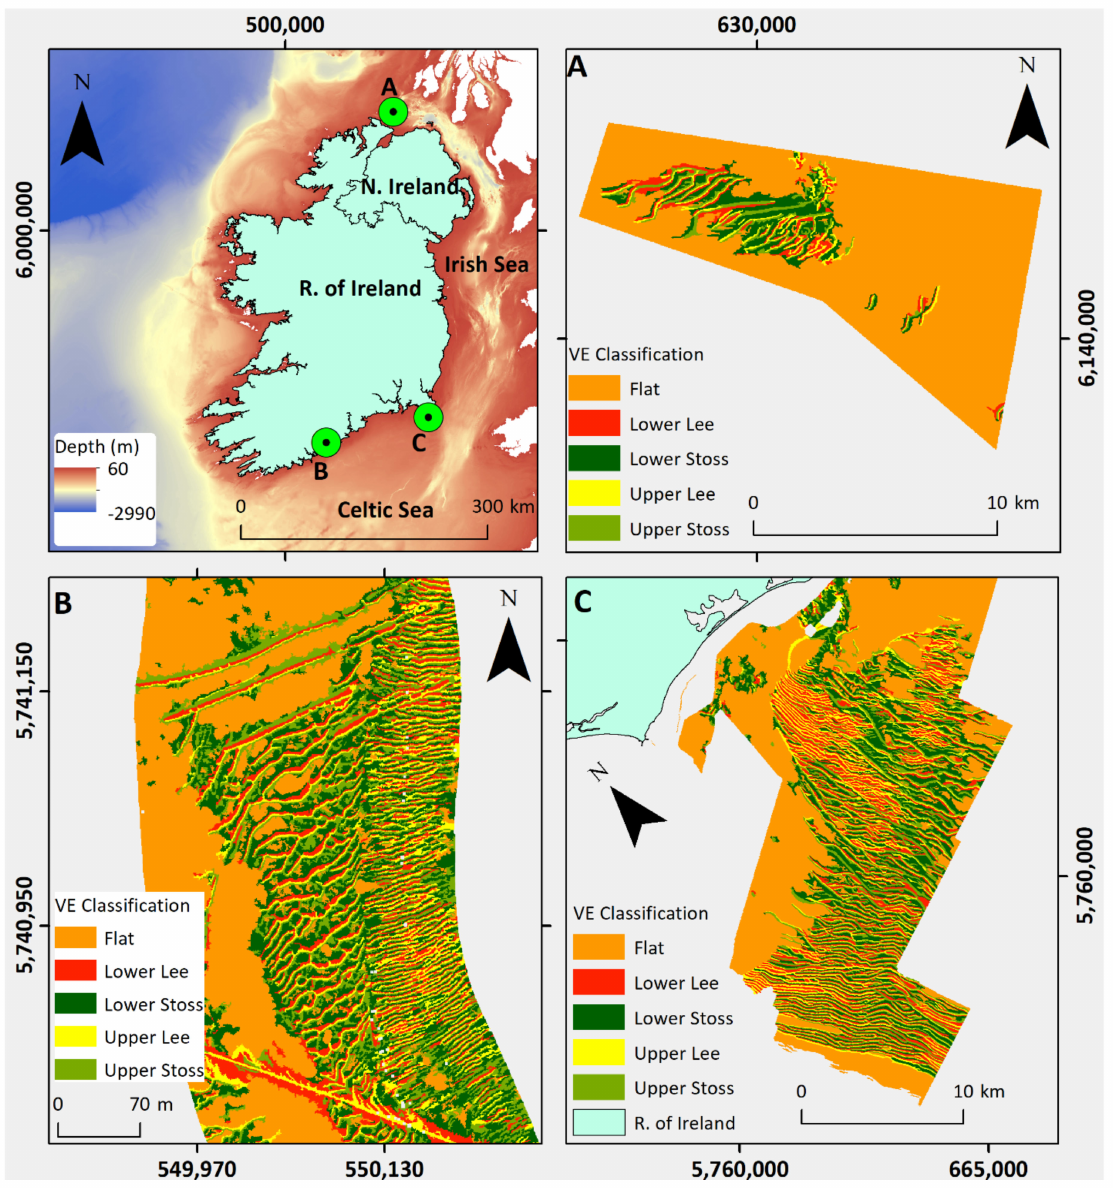
Figure 8. VE classification maps for the ( A ) HTB SAC, ( B ) Cork Harbour, and ( C ) South OSW sites. These misclassification clusters are observed within the northern portion of the OSW site. One hundred and forty-four image objects misclassified as either “Upper Lee” or “Lower Lee” by the VE classifier (68.2%) are also misclassified by the SVM, MLP1, and MLP2 classifiers. Eighty of these common misclassifications occur in the convergence region between the SW OSW and SE OSW subset sites; see Figure 9A–C. When calculating the mean for the features extracted from these misclassified objects, the mean values